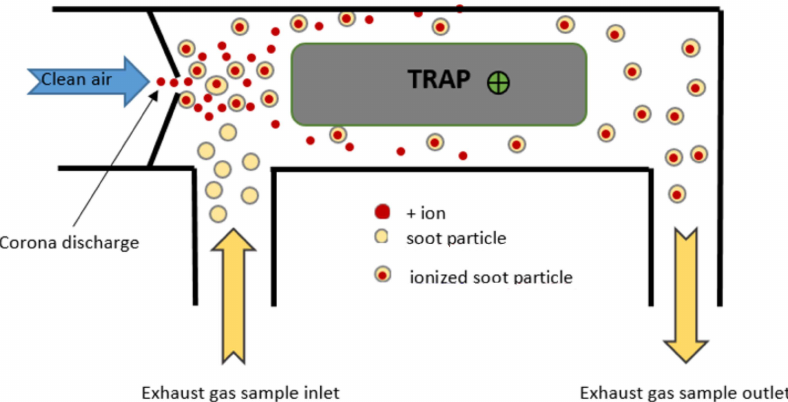
Figure 3. Schematic of the PPS